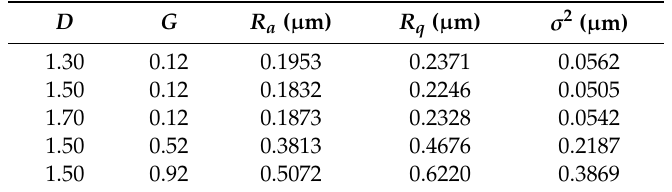
Table 2. The characterization parameters of surface profile with di ff erent D and